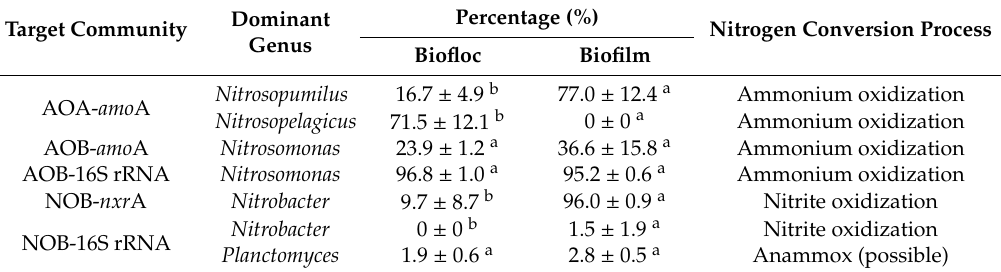
Table 4. Percentage and nitrogen conversion process of involved main nitrifying microbial communities between biofloc and biofilm from the biofloc-RAS for shrimp intensive culture in a 70-day